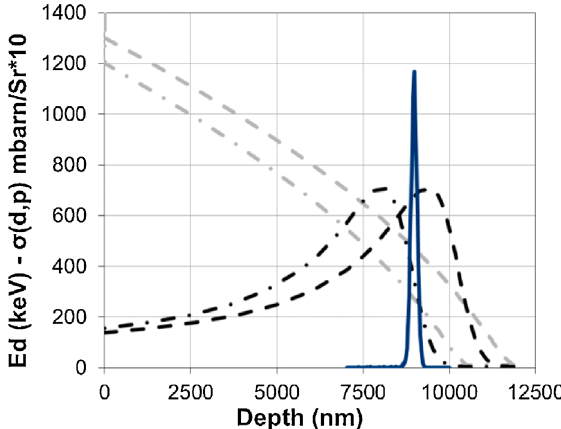
Fig. 5. Calculations for the choice of the energy of the deuterons (between 1200 keV: - · - and 1300 keV: - -) for the (d,p) reaction. Grey: energy of the deuterons versus depth into the material, from SRIM [19]. Black: cross-sections curves according to the initial deuterons energy and along the depth in the material. Blue solid line: implantation pro fi le of helium-3 at 3 MeV in B 4 C.